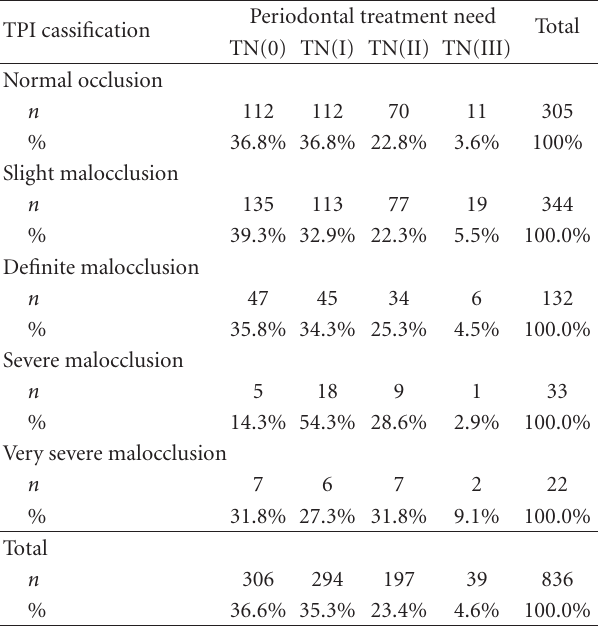
Table 6: Correlation coe ffi cients between CPITN, TPI, and DMFT scores. CPITN TPI